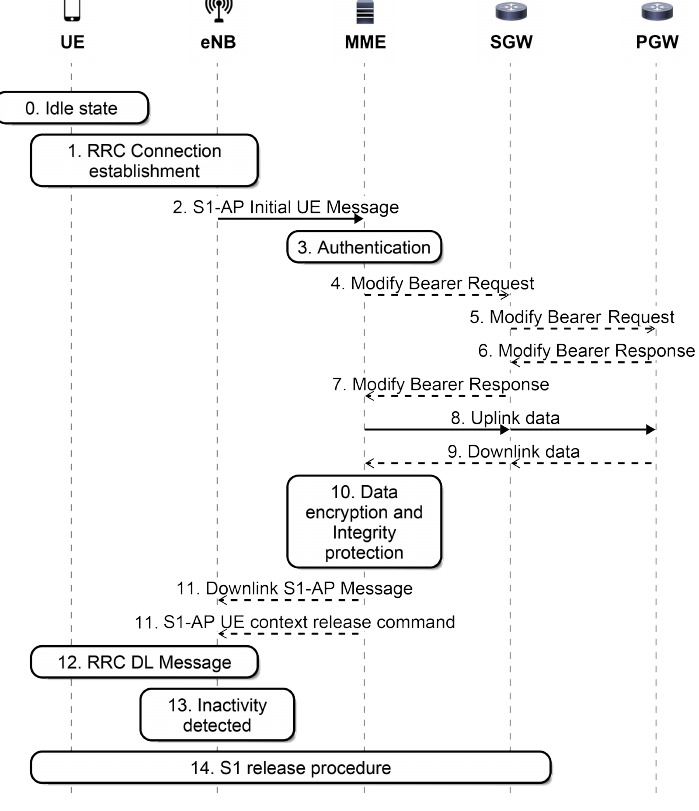
Figure 1. Mobile-originated data transport in the NAS packet data unit